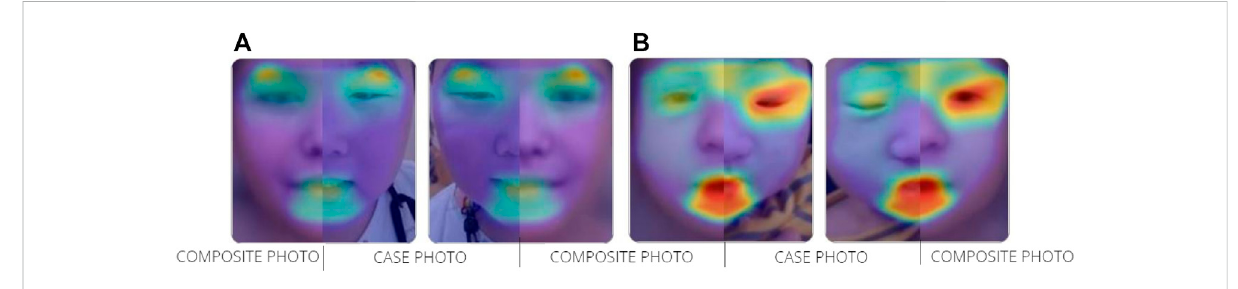
FIGURE 1 Overlapping facial regions of case photo and composite photo are indicated by the colored halo from red to blue (A) TBRS (B)